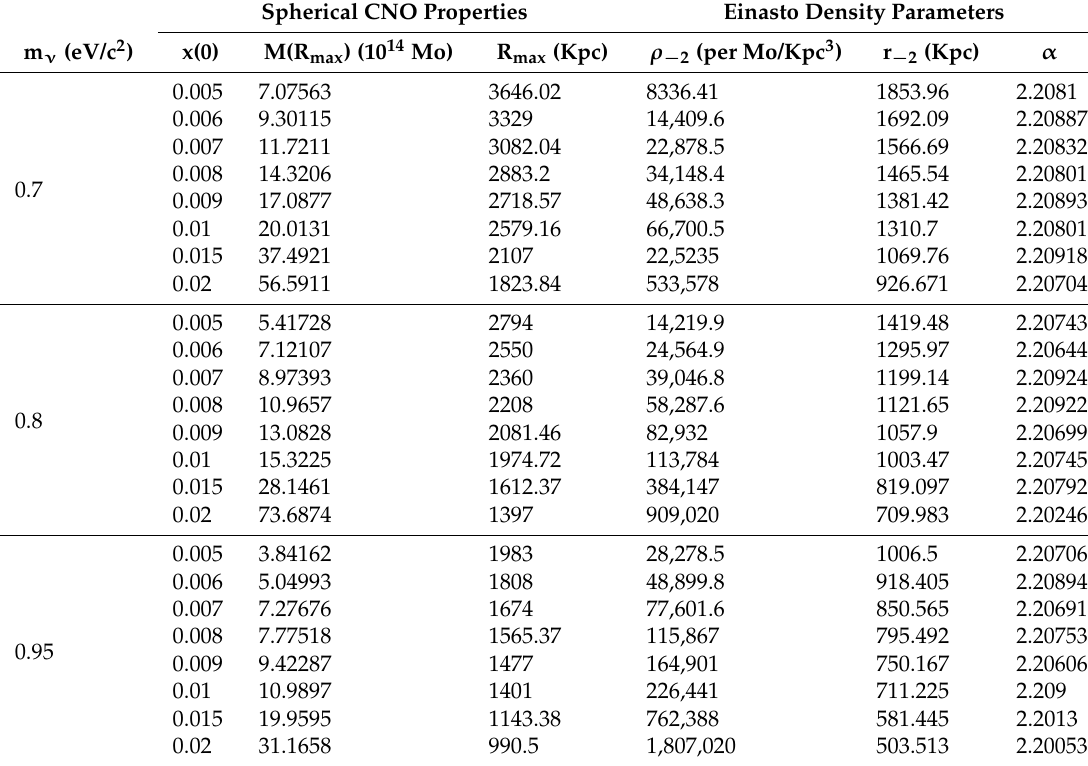
Table 3. Einasto density fit parameters for three cases of degenerate neutrino